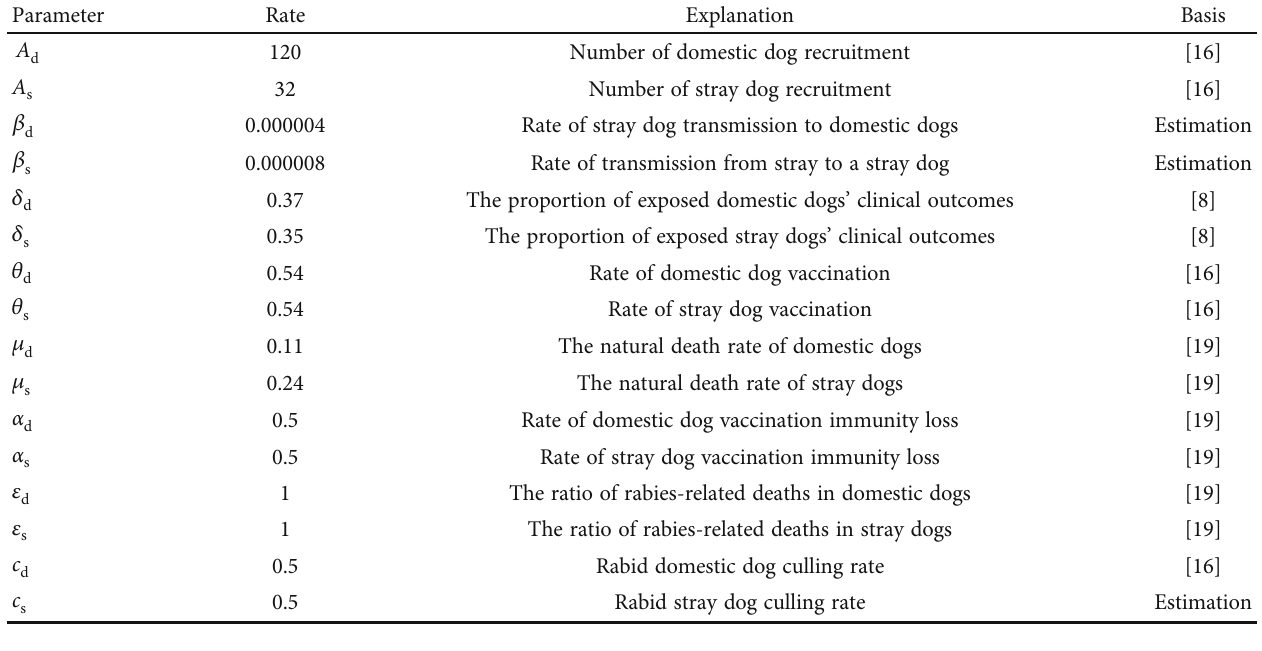
Table 4: Sensitivities of R